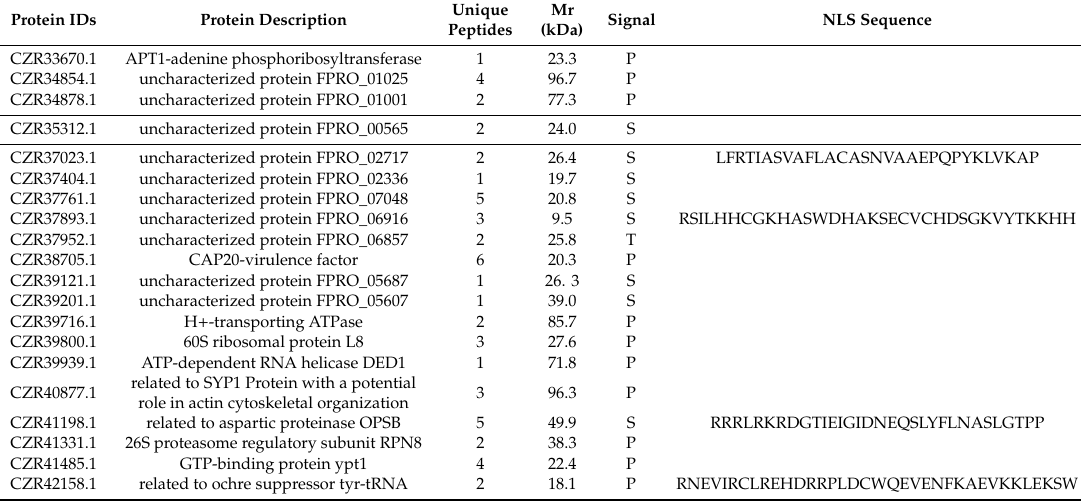
Table 1. Summary of the secreted proteins of F. proliferatum only identified in the + BP sample. Mr: Molecular weight. P: positive results from SignalP; S: positive results from SecretomeP; T: positive results from